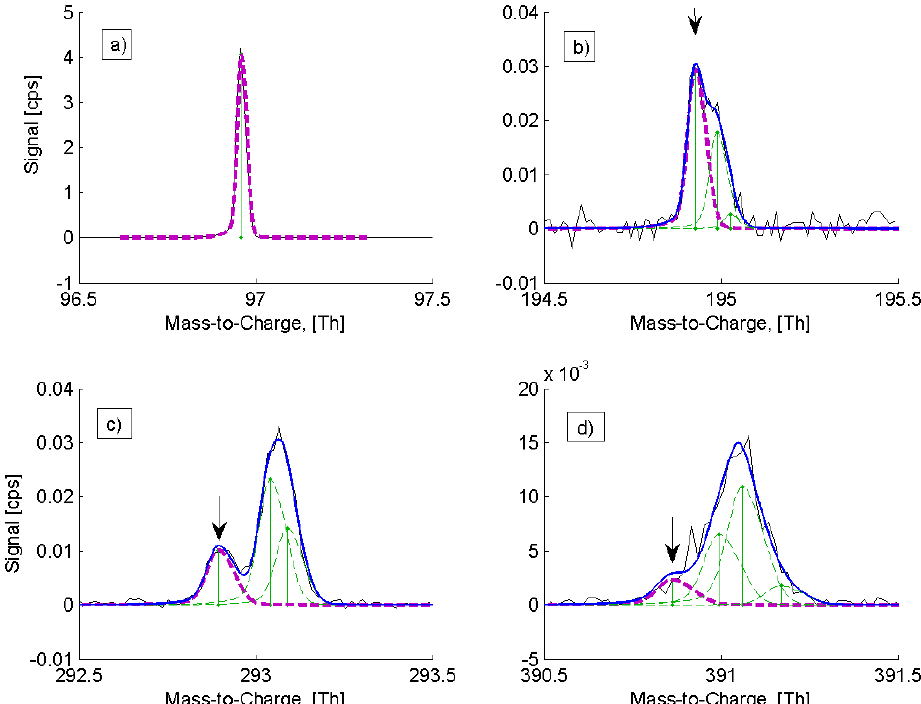
Fig. 2. Peak fitting for sulphuric acid monomer (a) , dimer (b) , trimer (c) and tetramer (d) clusters at integer mass 97Th, 195Th, 293Th and 391Th on 30 March 2011 at 10:00a.m. measured with the CI-APi-TOF. The dashed purple lines correspond to the sulphuric acid signals. Isotopic patterns are not provided in the figure but were used to confirm accurate peak identification in addition to the exact masses. Signals are averaged over 120 minutes.